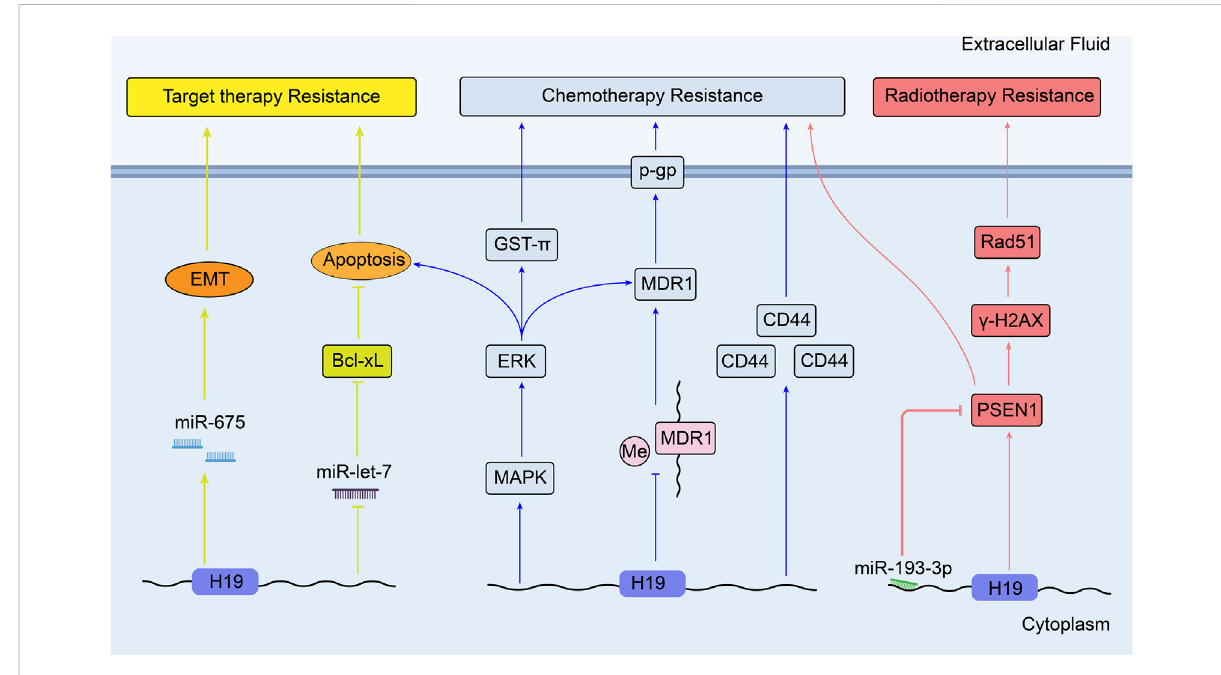
FIGURE 3 Overview of the role of H19 in modulating liver cancer therapy